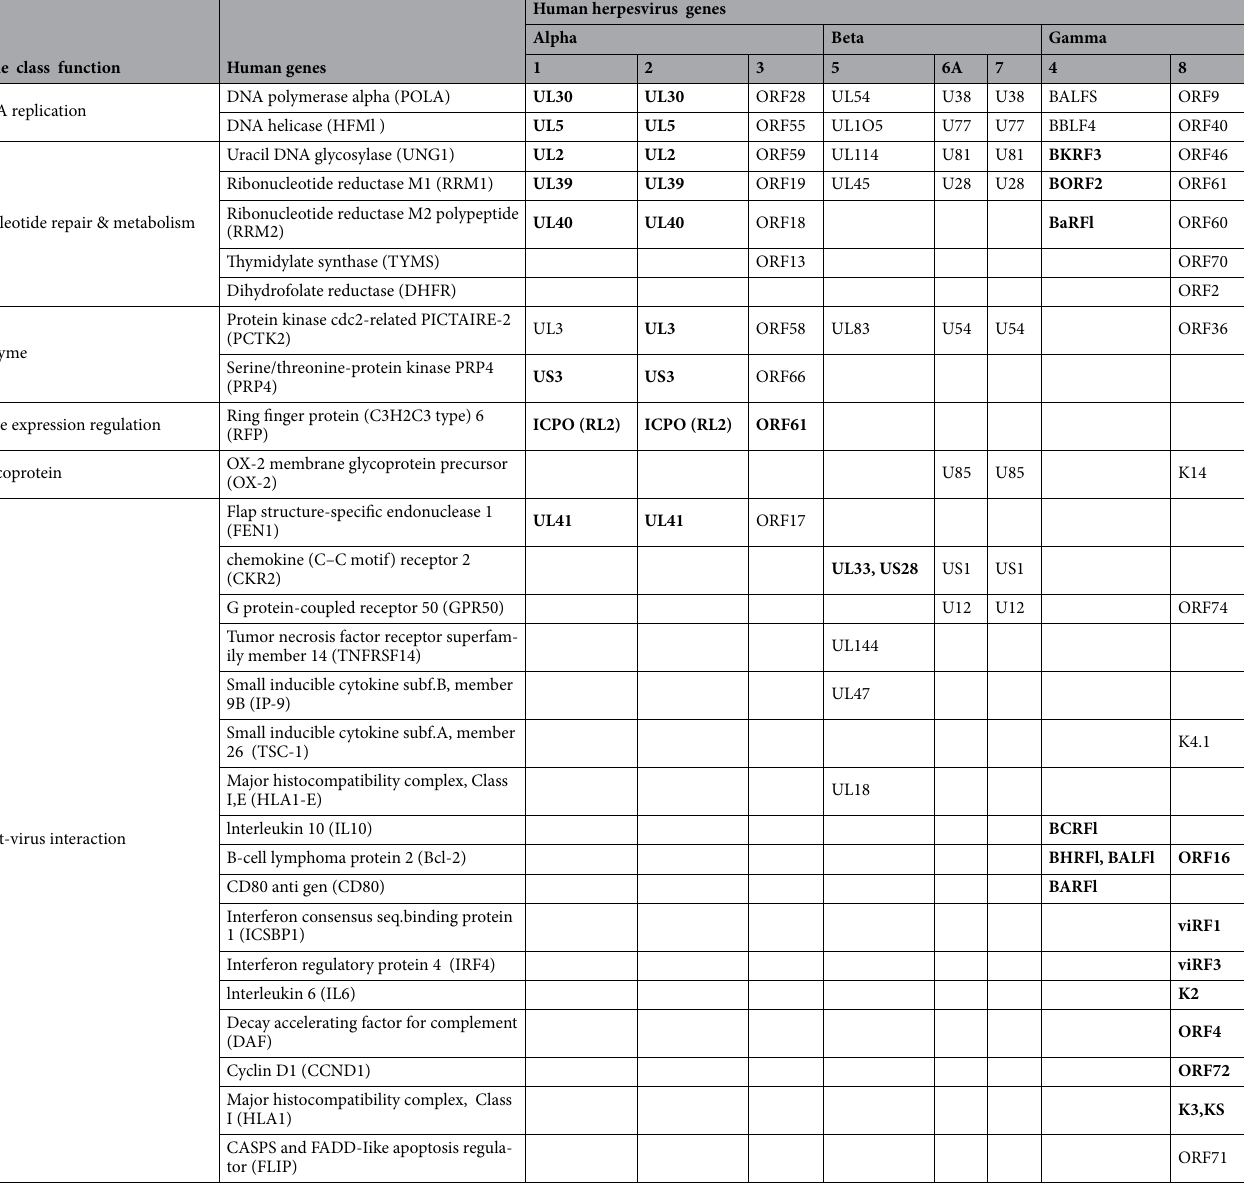
Table 1. PQS motifs in promoters of h uman herpesvirus homologues belonging to different functional classes. All human herpesvirus gene homologues of human genes were broadly classified into 6 functional groups based on gene function. The viral genes with ≥ 1 PQS motif in their 1 kb upstream regulatory region (promoter region) are represented in bold